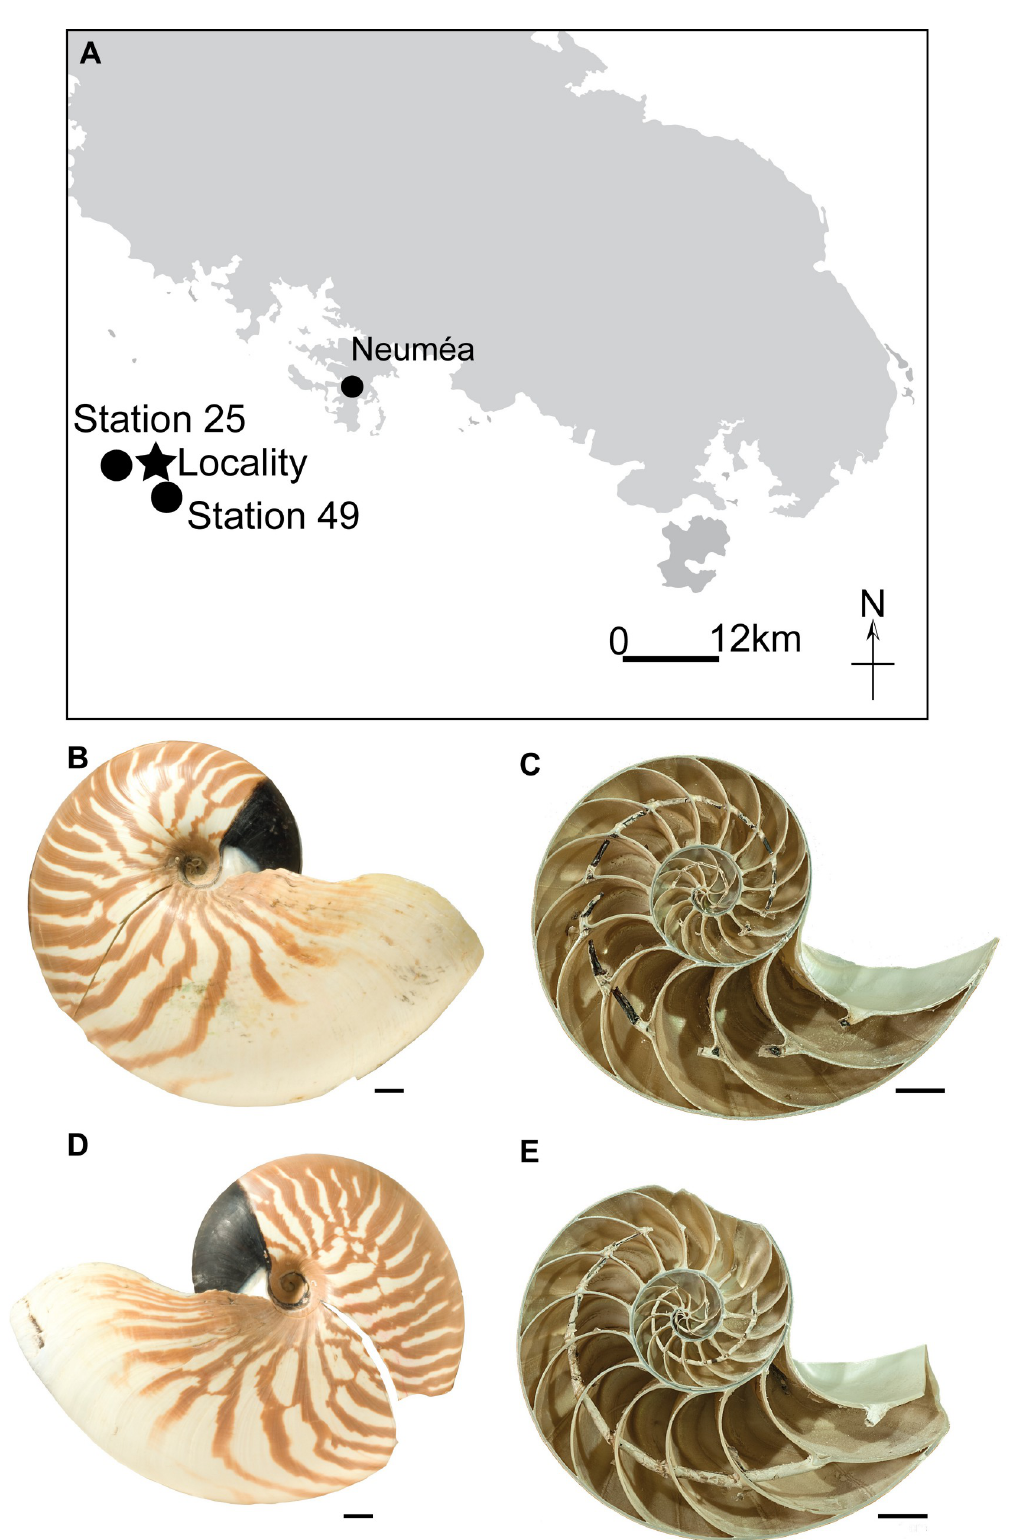
Fig 1. Study area and specimens. Map of New Caledonia. Star indicates the locality at which the specimens were caught. Circles indicate two stations at which water samples were taken (A); Outer shell of Nautilus macromphalus (AMNH 132380;